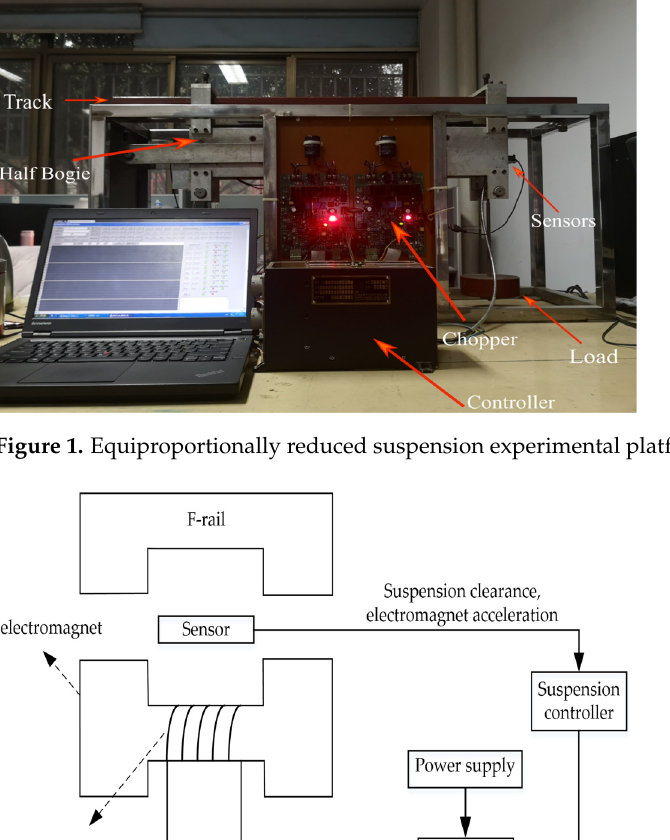
0 μ Figure 3. Structure model of single electromagnet.